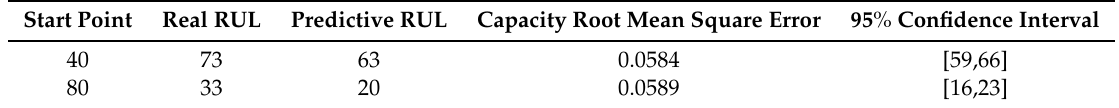
Table 3. RUL prediction results of the B6 battery using standard PF.